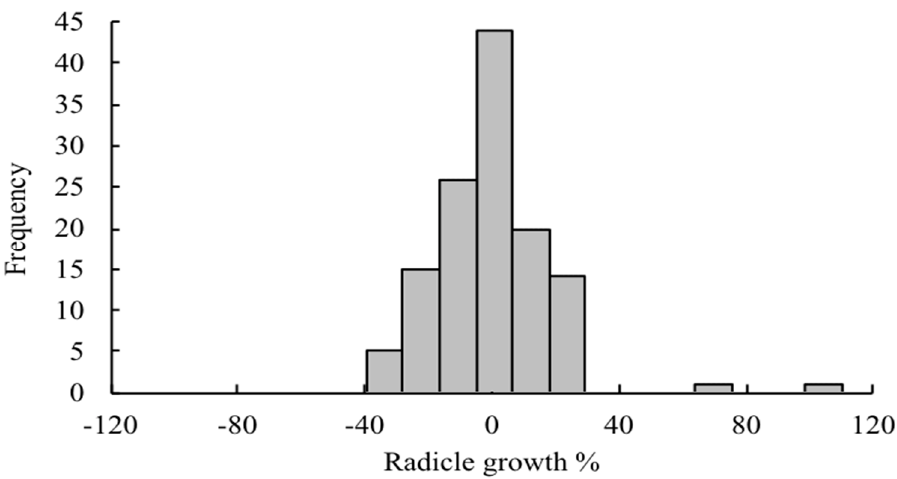
Figure 1. Distribution of plant species according to their radicle growth of lettuce.